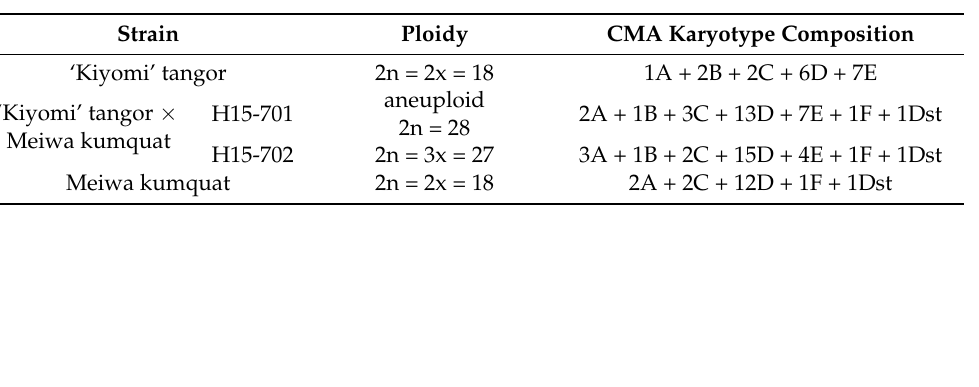
Figure 3. Idiograms of CMA banding patterns according to Yamamoto and Tominaga (2003) and Yamamoto et al. (2007). A = two telomeric bands and one proximal band, B = one telomeric and one proximal band, C = two telomeric bands, D = one telomeric band, E = no band, F = one proximal band, and Dst = type D with a satellite chromosome. Table 2. CMA karyotype compositions of ‘Kiyomi’ tangor, Meiwa kumquat, and their